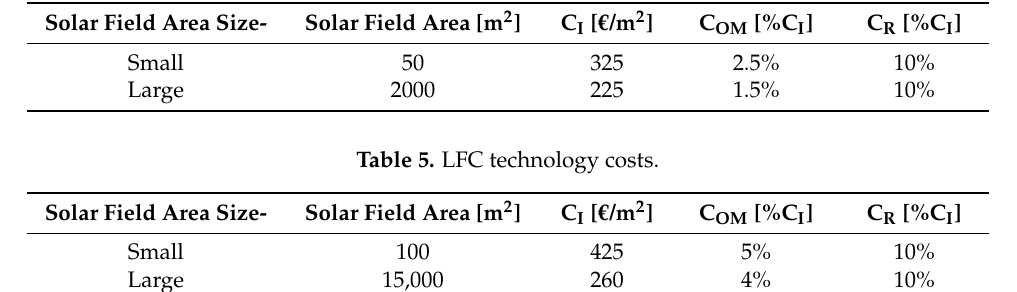
Table 4. CPC technology costs.